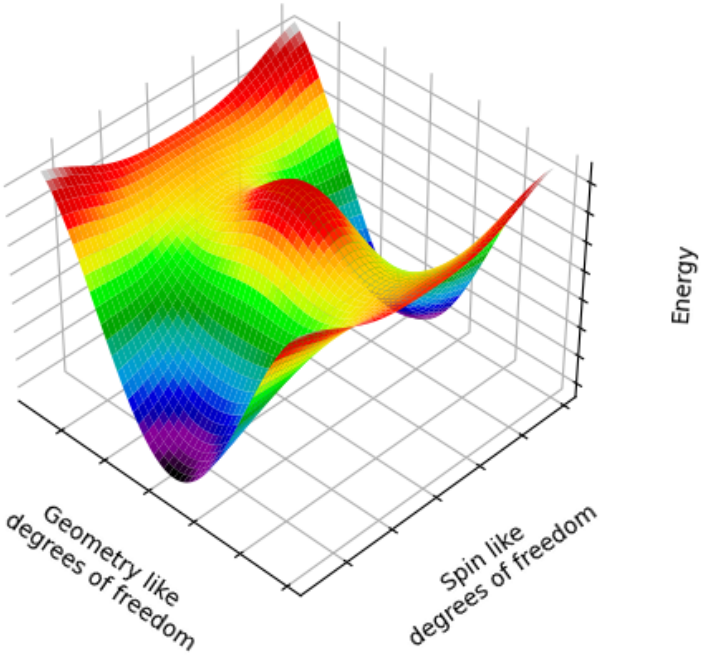
Figure 1. A cartoon schematic of the energy landscape for inverting the magnetic ordering in a domain. Note that the lowest energy route passes through a saddle-point which has a different geometry to the ground state of the magnetic easy axis. Note that all magnetic degrees of freedom are compressed into a single axis, and all geometric degrees of freedom are compressed into